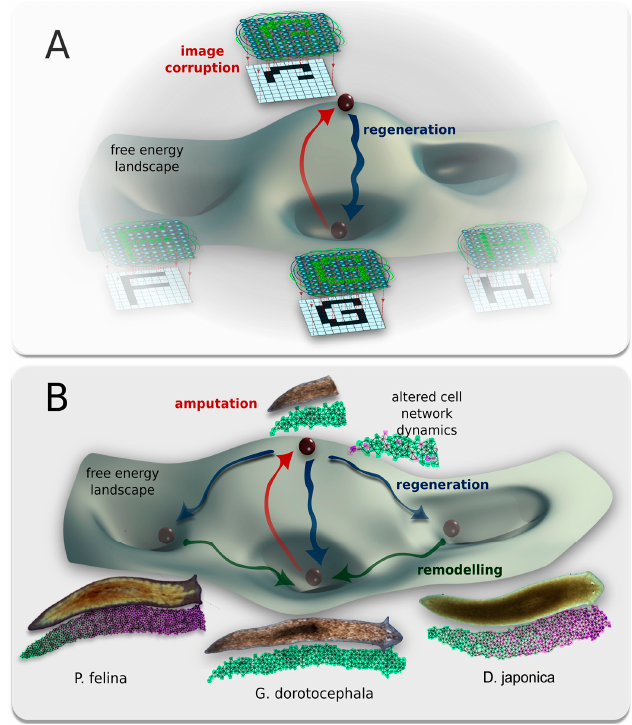
Figure 9. A conceptual model of shape change driven by physiological network dynamics. Planaria regeneration parallels classical neural network behavior; both can be described in terms of free energy landscapes with multiple attractor states. ( A ) Behavior of a classical Hopfield neural network trained to reproduce three types of patterns, in this case shapes of the letters “F”, “H”, or “G”, which are the three stable states of the network’s free energy landscape. The state of the Hopfield network’s nodes directly relate to the brightness of pixels on a display, generating output. Perturbation of the network from a stable state (red arrow) by deleting (damaging) part of the pattern is akin to moving a ball to an unstable point on the free energy landscape, and leads to regeneration of the closest learned attractor state (blue arrow). In this, such networks’ well-known ability to implement memory is analogous to regenerating organisms restoring a specific target morphology upon damage; ( B ) The parallel concept of planaria regeneration into head shapes of one of three different species, which are attractor states of the free energy landscape. Outcome morphology is driven by the dynamic outputs of physiological cellular network. Amputation (red arrow) is akin to moving the system to an unstable point on the free energy landscape. Normal regeneration would return the system to its main attractor, but altering cell network dynamics via gap junction blockade allows for regenerative transitions (blue arrow) to alternative local minima, corresponding to morphospace regions normally occupied by P. felina and S. mediterranea worms. In time, remodeling (green arrow) transfers these morphologies to the global minimum of the wild-type state ( G. dorotocephala ).